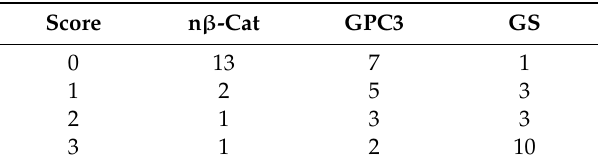
Table 2. n β -Cat, GPC3, and GS Protein Expression (Score 0–3) in all 17 Patients Tested. Score 0, ≤ 5% 3, > 60% Positive Tumor